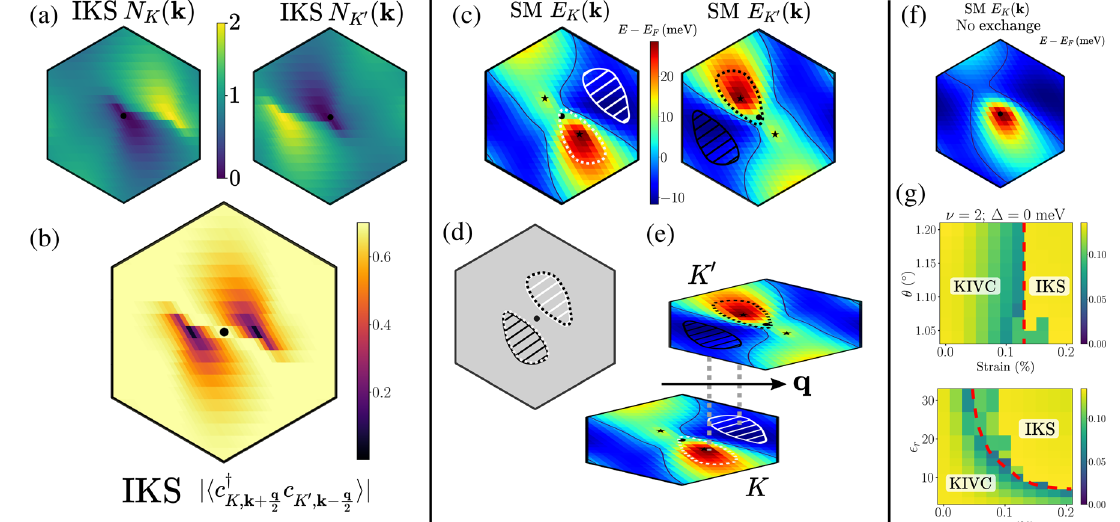
FIG. 4. mBZ-resolved properties of the IKS state at ν ¼ − 2 . (a) Valley populations of the IKS state. (b) Frobenius norm of the IVC at wave vector q ¼ G 1 = 3 . System size is 48 × 16 , strain is 0.2%, substrate is Δ ¼ 0 meV, and NLT is not included. (c) Dispersions of the lower band for the metastable symmetry-preserving self-consistent SM. Hatched (dotted) lobes, situated near low- (high-) energy regions, will be predominantly filled (empty) in the IKS state. Black lines indicate the Fermi surface, and black stars mark Dirac point locations. (d),(e) Schematic construction of the IKS state — a relative momentum boost of the valleys by q allows the lobes to overlap each other. Regions not within the lobes participate strongly in IVC. (f) HF spectrum for the same density matrix used in (c) except that exchange is neglected. (g) ν ¼ þ 2 HF phase diagram in the strain-twist angle plane and the strain-relative permittivity plane. System size is 12 × 12 .